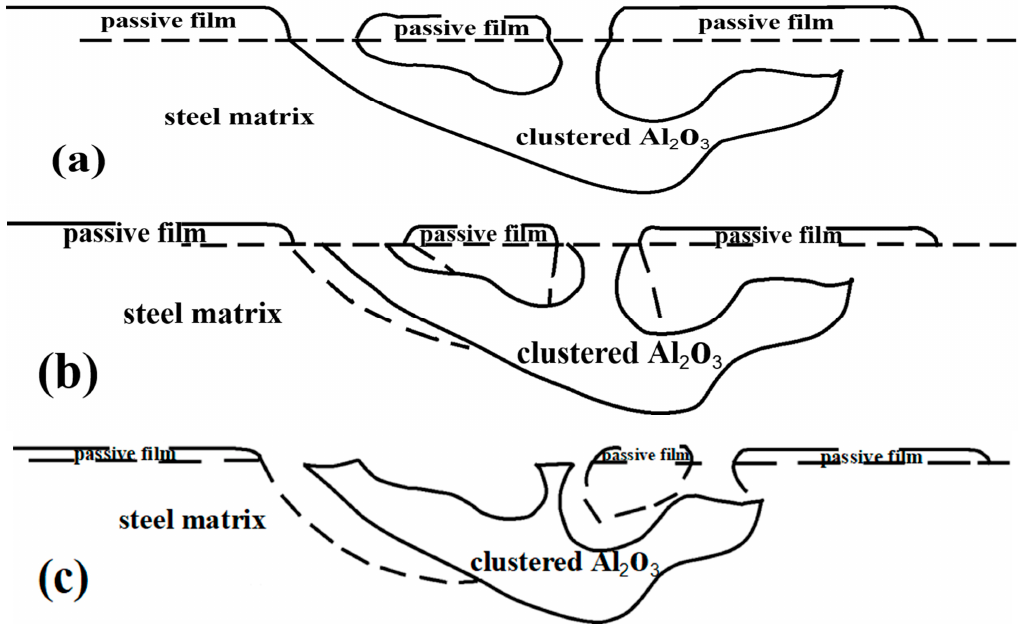
Figure 12. Corrosion mechanism diagram: ( a ) before corrosion; ( b ) during corrosion; ( c ) after corrosion